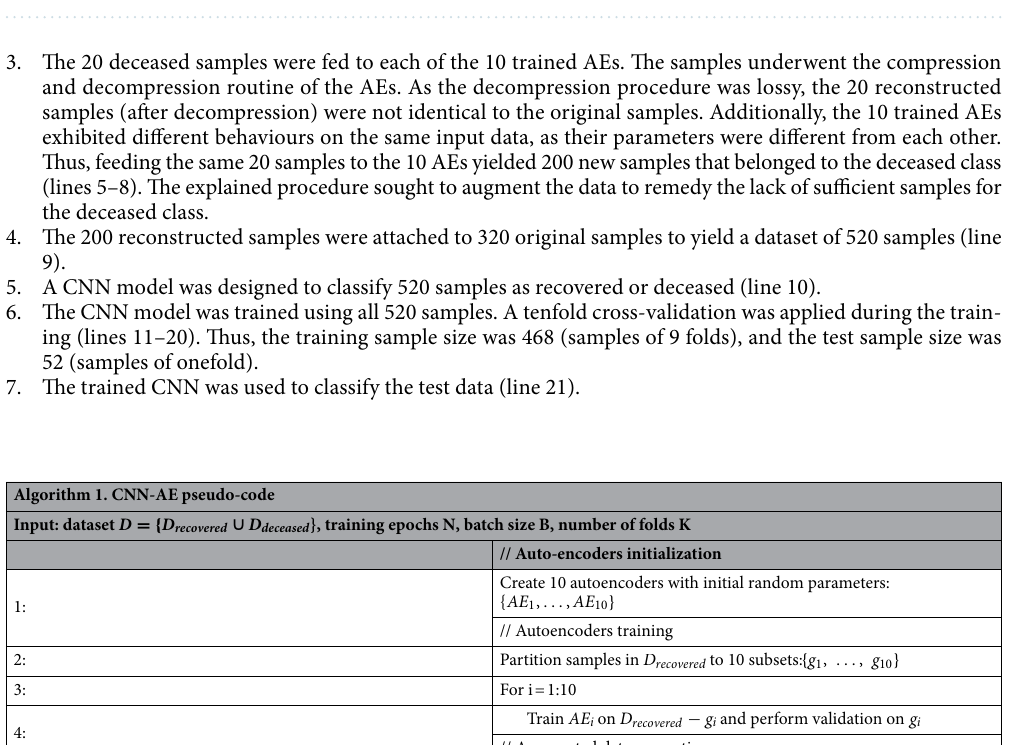
Figure 5. The steps for implementing the proposed